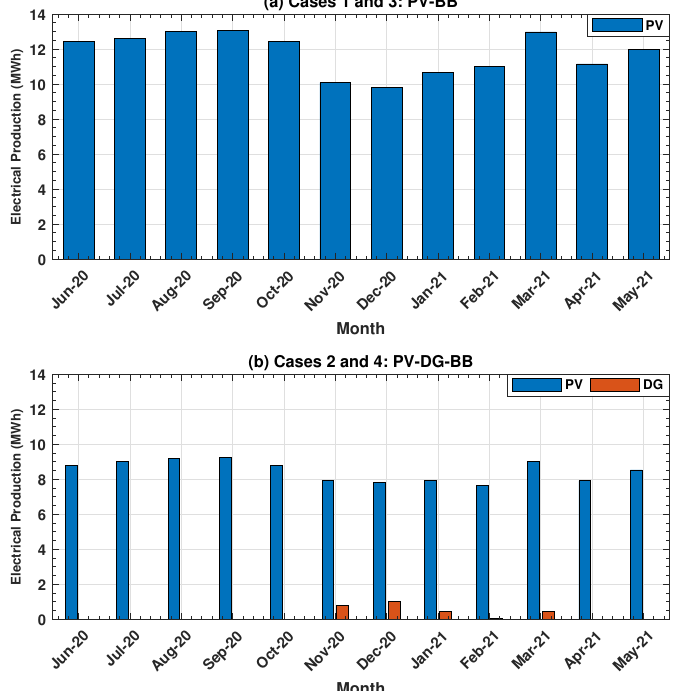
Figure 10. Monthly energy production at Wafra cell-site for: ( a ) Cases 1 and 3: PV-BB, and ( b ) Cases 2 and 4: